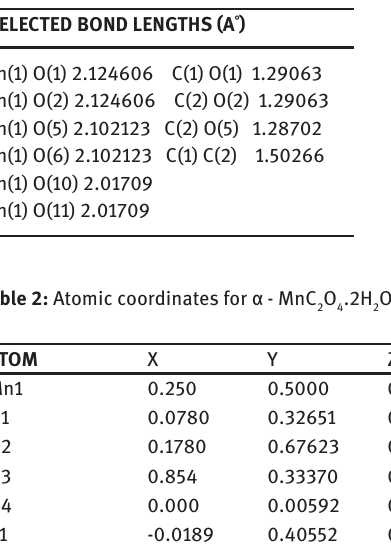
Table 1: Selected bond lengths (A˚) for α - MnC